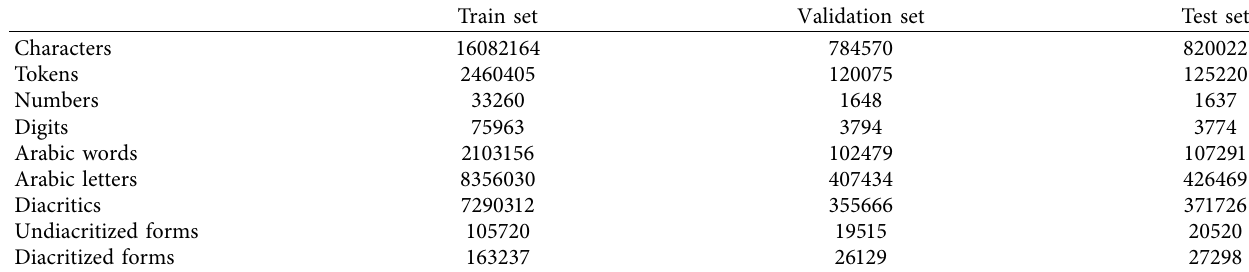
Table 2: Some statistics about the corpus splits used in this study.